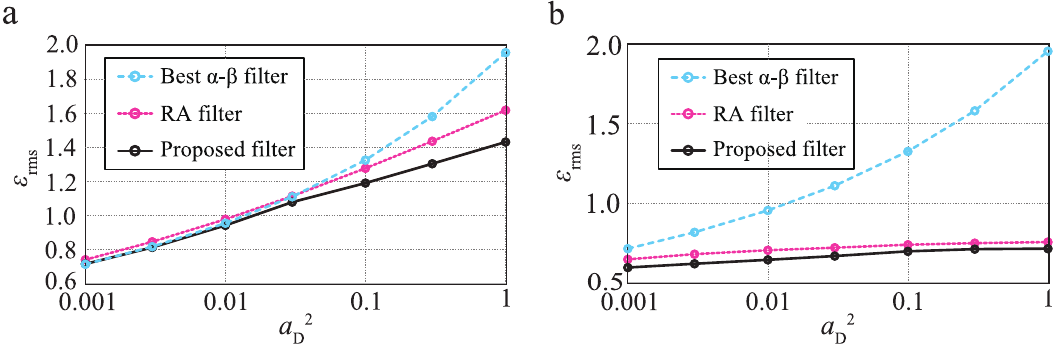
Figure 1. Relationship between a D and (cid:101) rms for ( a ) R xv = 1 and ( b ) R xv = 10; RA: